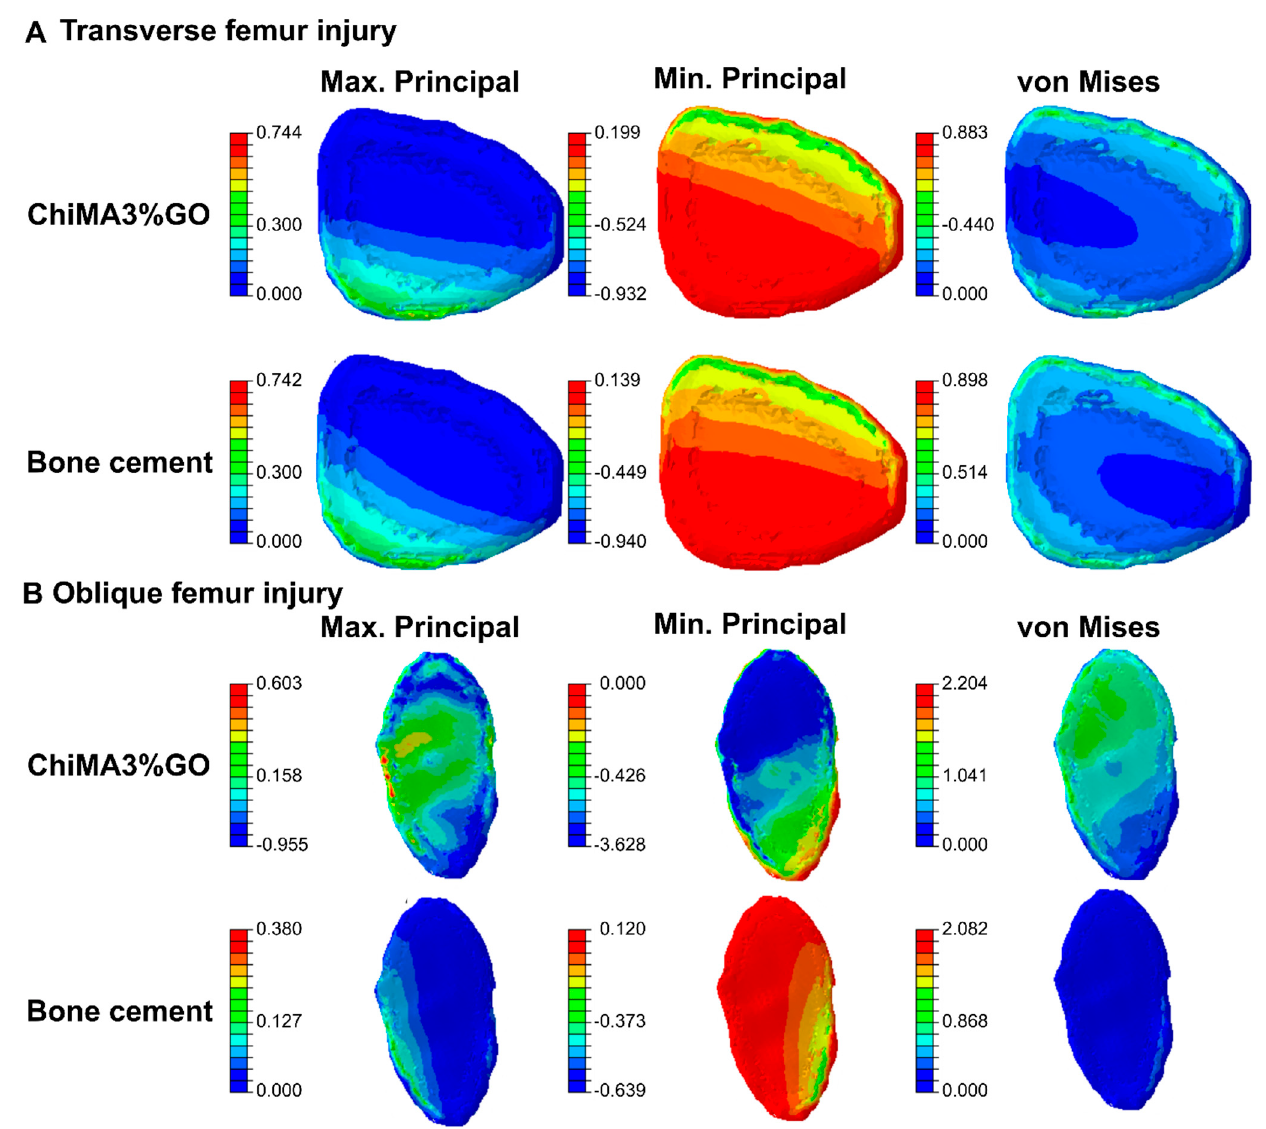
Figure 11. Distribution of tensile and compressive forces over ChiMA3%GO- and bone cement-repaired femurs under the effect of hip momentum. Maximum principal, minimum principal, and von Mises stresses are shown for ( A ) the transverse lesion and ( B ) the oblique